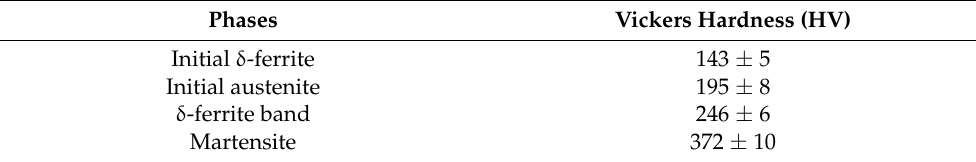
Figure 5. ( a ) Vickers hardness test of the initial microstructures and ( b ) Vickers hardness test under deformation conditions of 950 ◦ C and 0.1 s − 1 . Table 2. Microhardness of the constituent